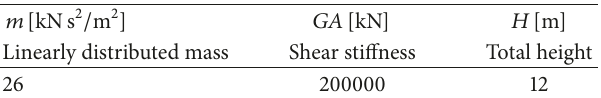
Figure 14: Sensors arrangement and first modal shape of the continuous structure. Table 12: Geometric parameters of the undamaged shear-deflecting cantilever beam.